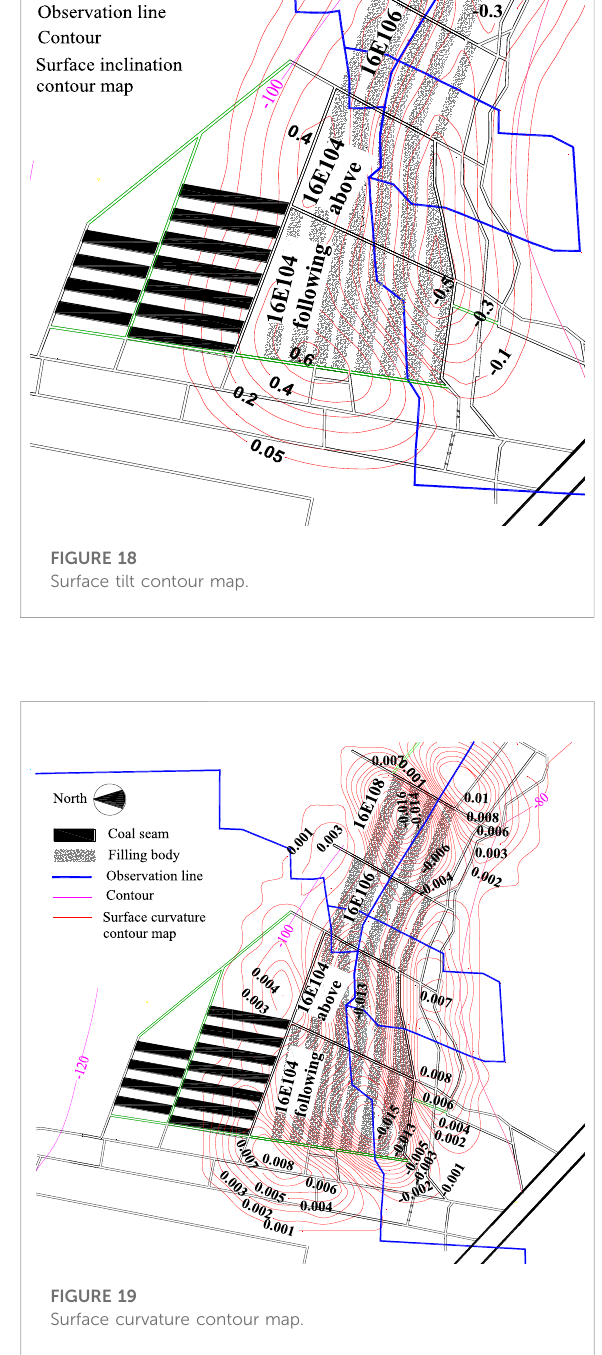
FIGURE 19 Surface curvature contour map.